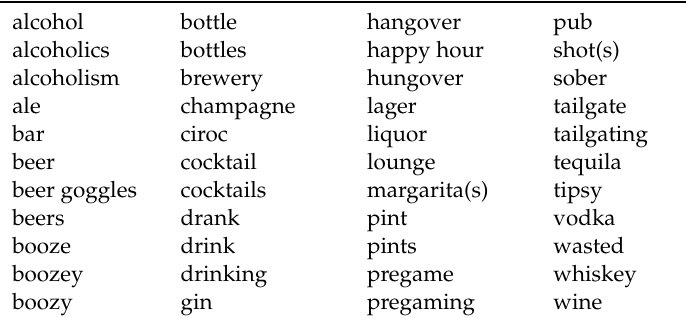
Table A1. Full list of drinking